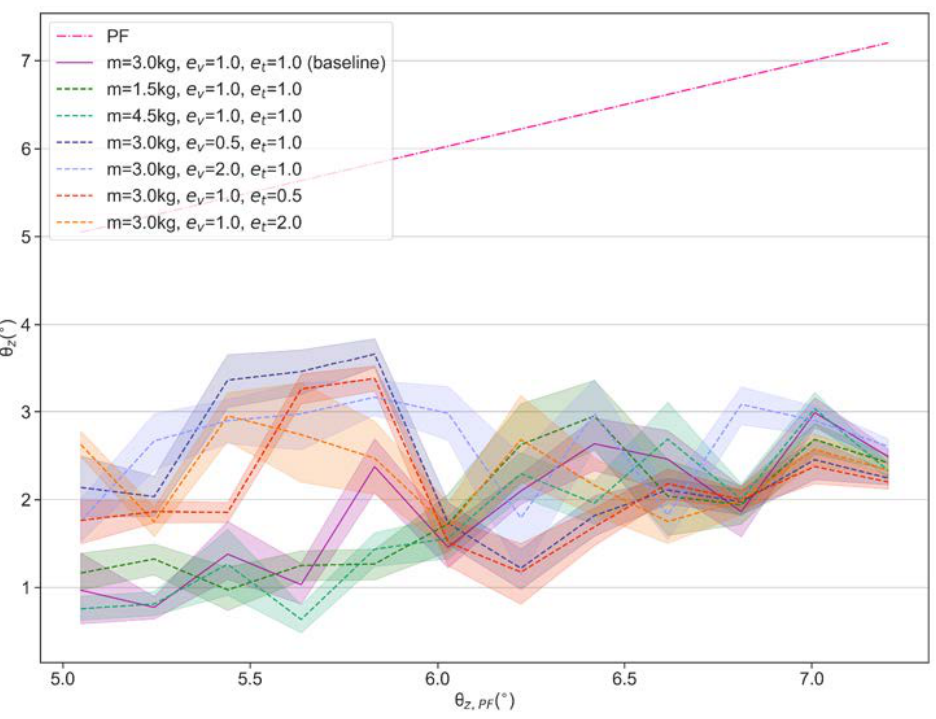
Figure 10. Balance performance under modified mass, velocities and torques.